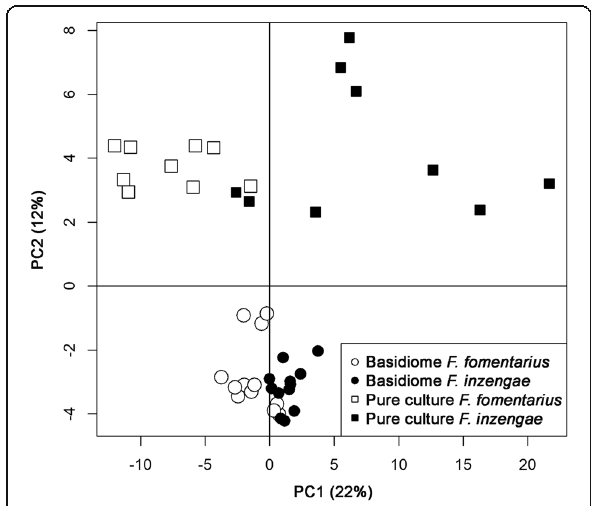
Fig. 8 VOC data exploration by unsupervised PCA analysis of all Fomes inzengae and F. fomentarius samples (232 peaks). Basidiome and pure culture samples are well separated by the second principal component (PC2 12.5%). Separation of F. inzengae from F. fomentarius is more pronounced in pure culture samples than